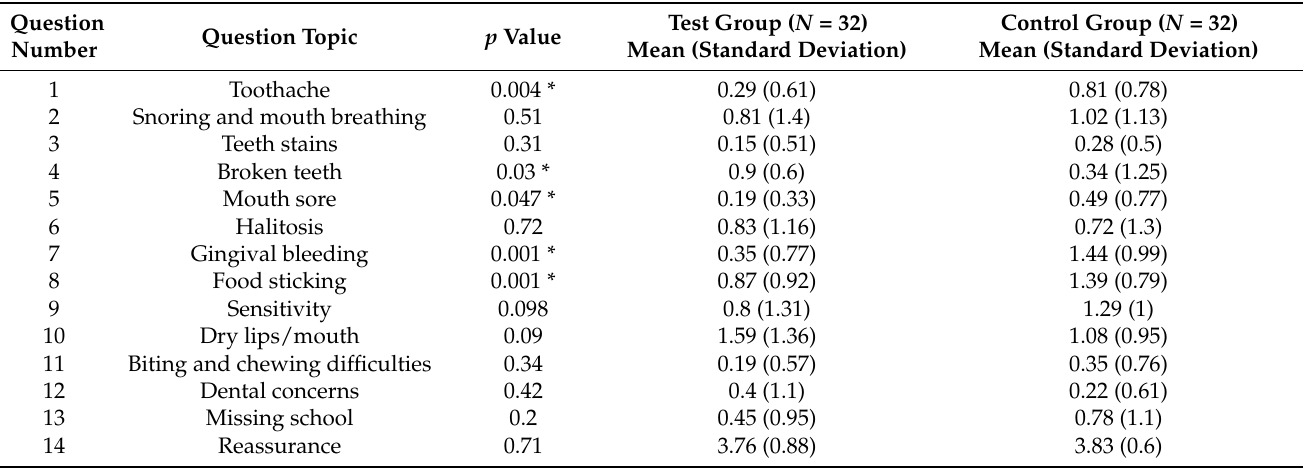
Table 2. Means and standard deviations of the scores attributed in the OHIP-14 questionnaire in the test group and in the control